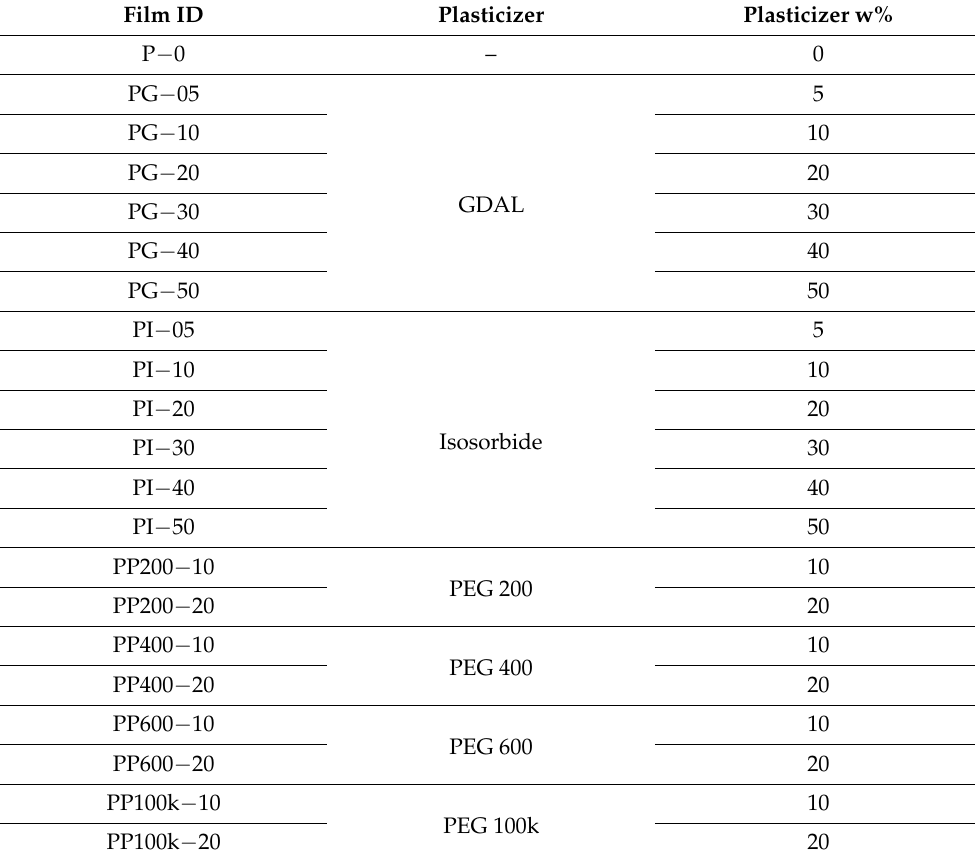
Table 1. PHBH films prepared with different plasticizers and different plasticizer